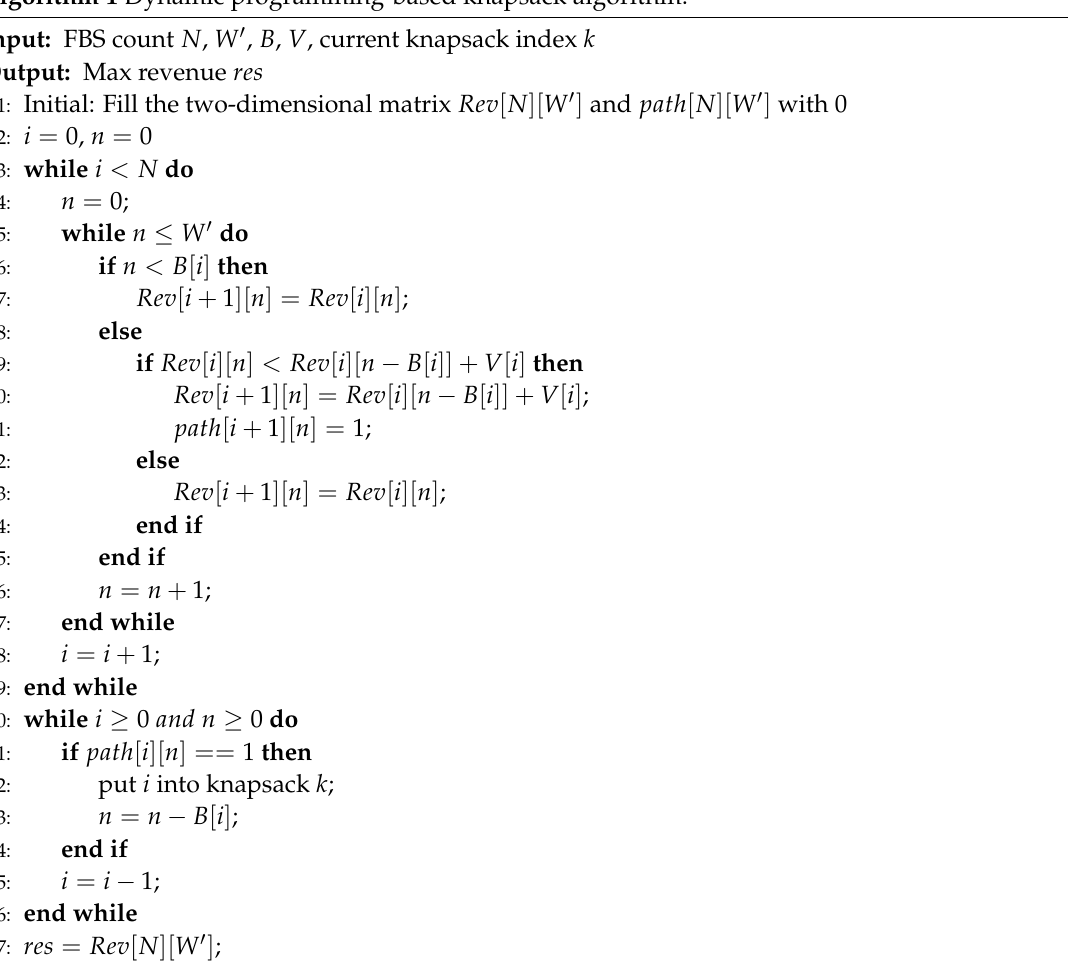
Algorithm 1 Dynamic programming-based knapsack